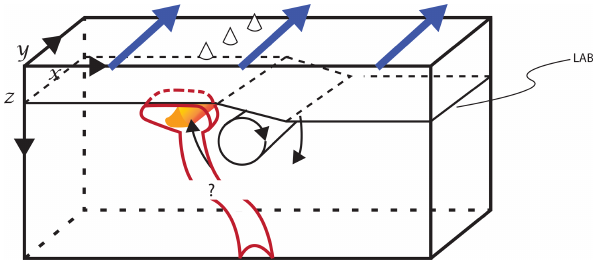
Figure 1. Schematic of a plume interacting with edge-driven con- vection. In this work, we build on the models of Manjón-Cabeza Córdoba and Ballmer (2021) and add a plume in the form of a temperature anomaly at the bottom and a plate velocity v plate = 2cmyr − 1 consistent with the age–distance track to the north of the Canary Islands. An idealized lithosphere–asthenosphere boundary (LAB) is labeled in the